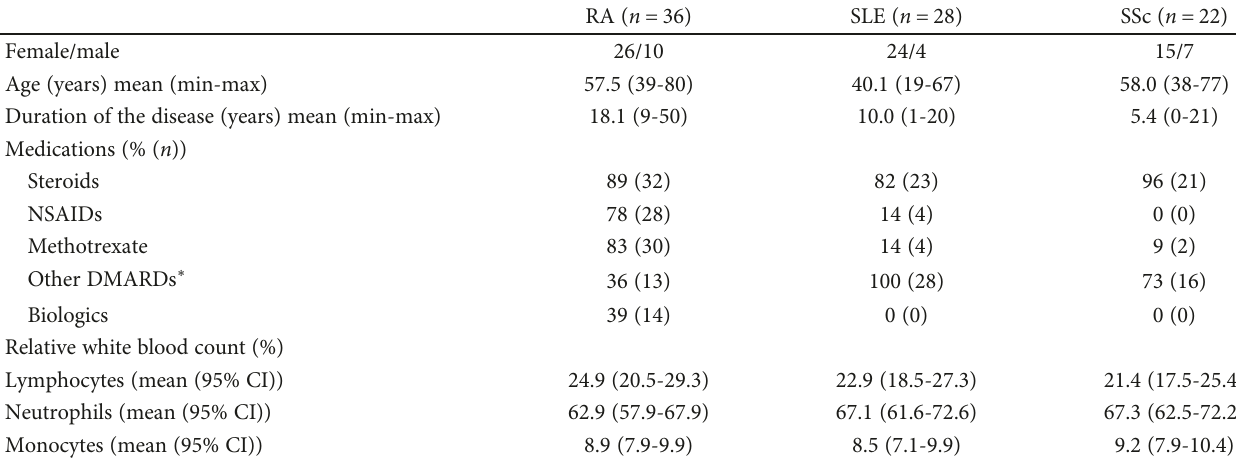
Table 1: Demographic and clinical characteristics of enrolled